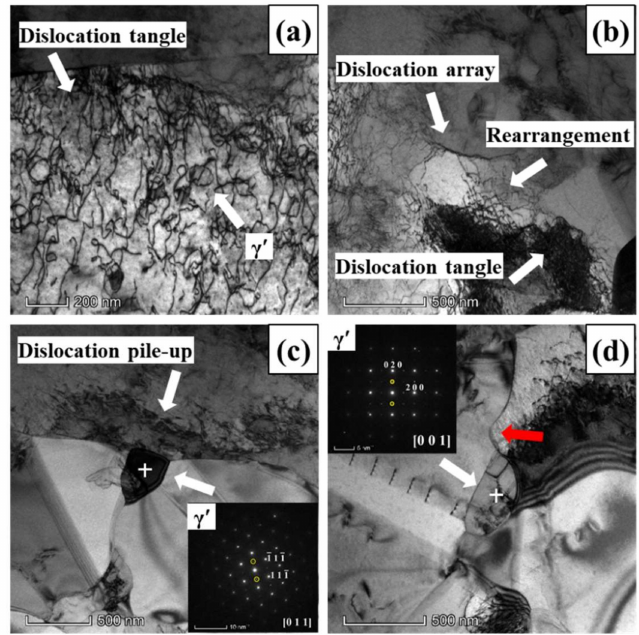
Figure 7. TEM morphology of GH4151 alloy after deformation at 1040 ◦ C, 0.1 s − 1 and strain of 0.1: ( a ) Dislocation tangle; ( b ) Dislocations; ( c ) Dislocation pile-up; ( d ) γ ’ particle pinning the grain